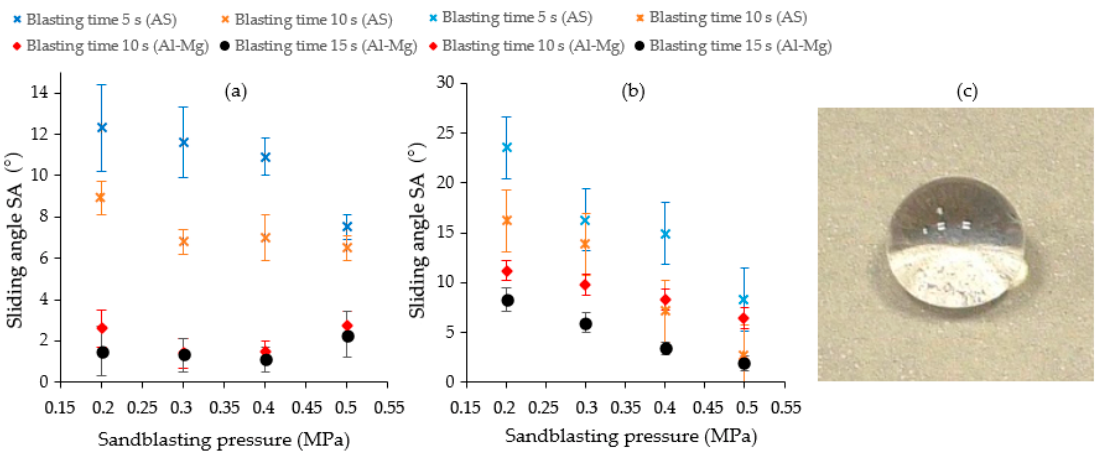
Figure 7. SA of 50 µL water drops on Al-Mg and AS substrates sandblasted at different pressures from 0.2 to 0.5 MPa for 5, 10, and 15 s and immersed in solutions of ( a ) cerium nitrate and ( b ) cerium chloride. ( c ) Image of water drop placed on a treated Al-Mg substrate sandblasted at 0.4 MPa for 15 s.